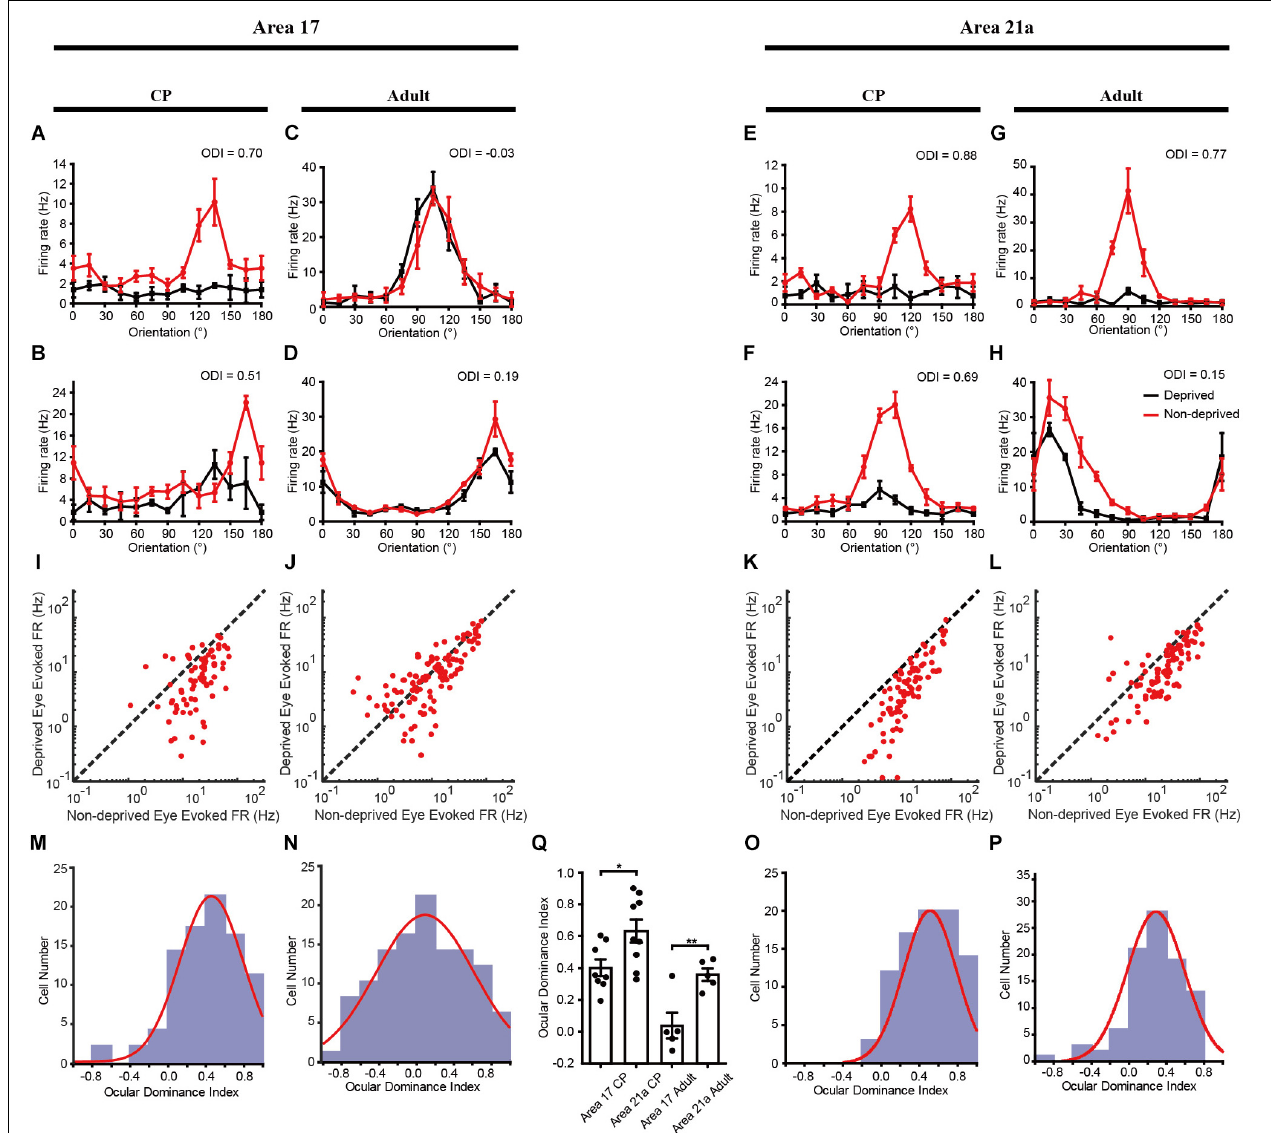
FIGURE 4 | Electrophysiological evidence of MD effect on cats of different ages in areas 17 and 21a. Orientation-tuning curves of example neurons in area 17 (A–D) and area 21a (E–H) to stimuli presented to the deprived eye (black lines) and the non-deprived eye (red lines). A comparison of the firing rates between the deprived and non-deprived eyes in area 17 ( I , during CP; J , in adulthood) and area 21a ( K , during CP; L , in adulthood). Each red dot represents a single neuron. Ocular dominance index distribution of all the recorded cells in area 17 (M,N) and 21a (O,P) from cats monocularly deprived during the CP (3 days, M,O ) or in the adult (7 days, O,P ). The red curve indicates a Gaussian fit to the data. (Q) Statistical analysis of the single-unit recording results on the ODI shift across animals. Each point represents the mean ODI from the cortical area of one animal, and the mean and standard error of ODI across animals is shown as a bar plot. ∗ p < 0.05, ∗∗ p <